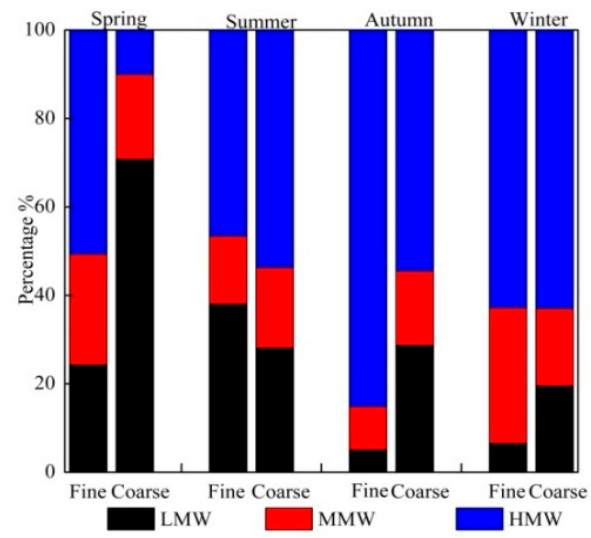
Figure 2. Distributions of different PAHs in fine and coarse particles.